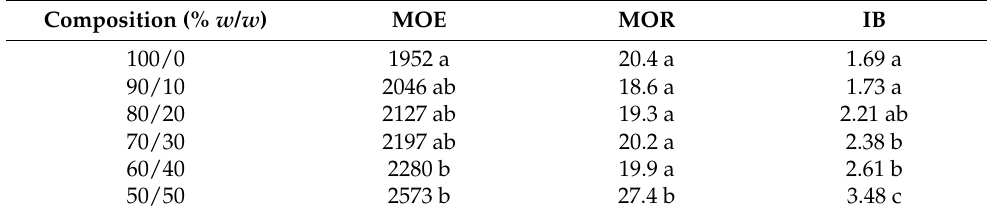
Table 7. Duncan multi-range-test of mechanical properties.